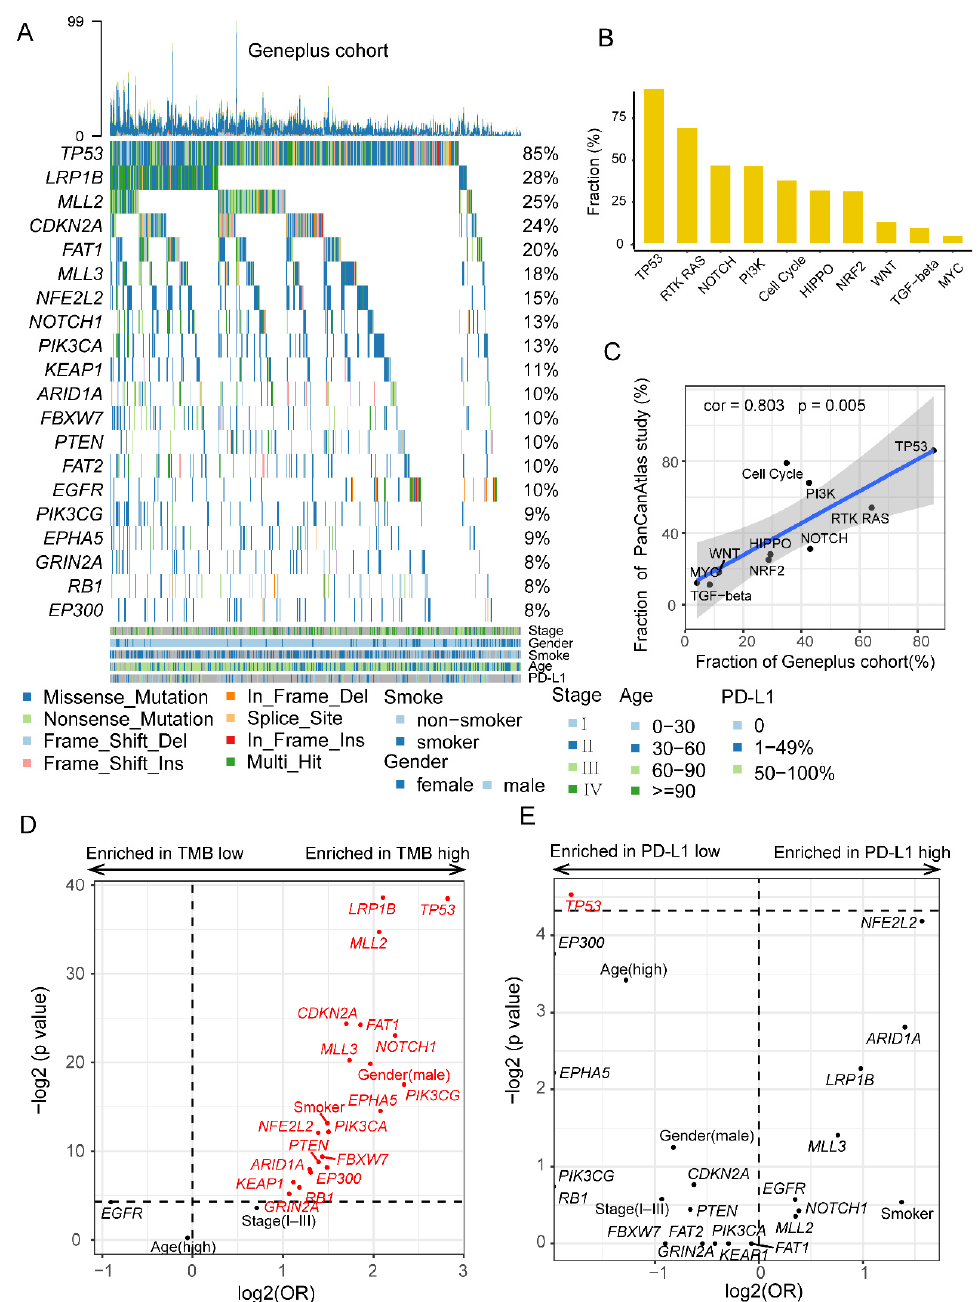
Figure 1. The mutational characteristics of patients with LUSC in Geneplus cohort. ( A ) The frequently recurrent genes in 525 LUSC patients. ( B ) The mutation frequency of ten carcinogenic signaling pathways in the Geneplus cohort. ( C ) The correlation between the mutation frequency of ten carcinogenic signaling pathways in the Geneplus cohort and PanCanAtlas study. ( D ) The clinical and mutational factors associated with TMB. ( E ) The clinical and mutational factors associated with PD-L1 expression.